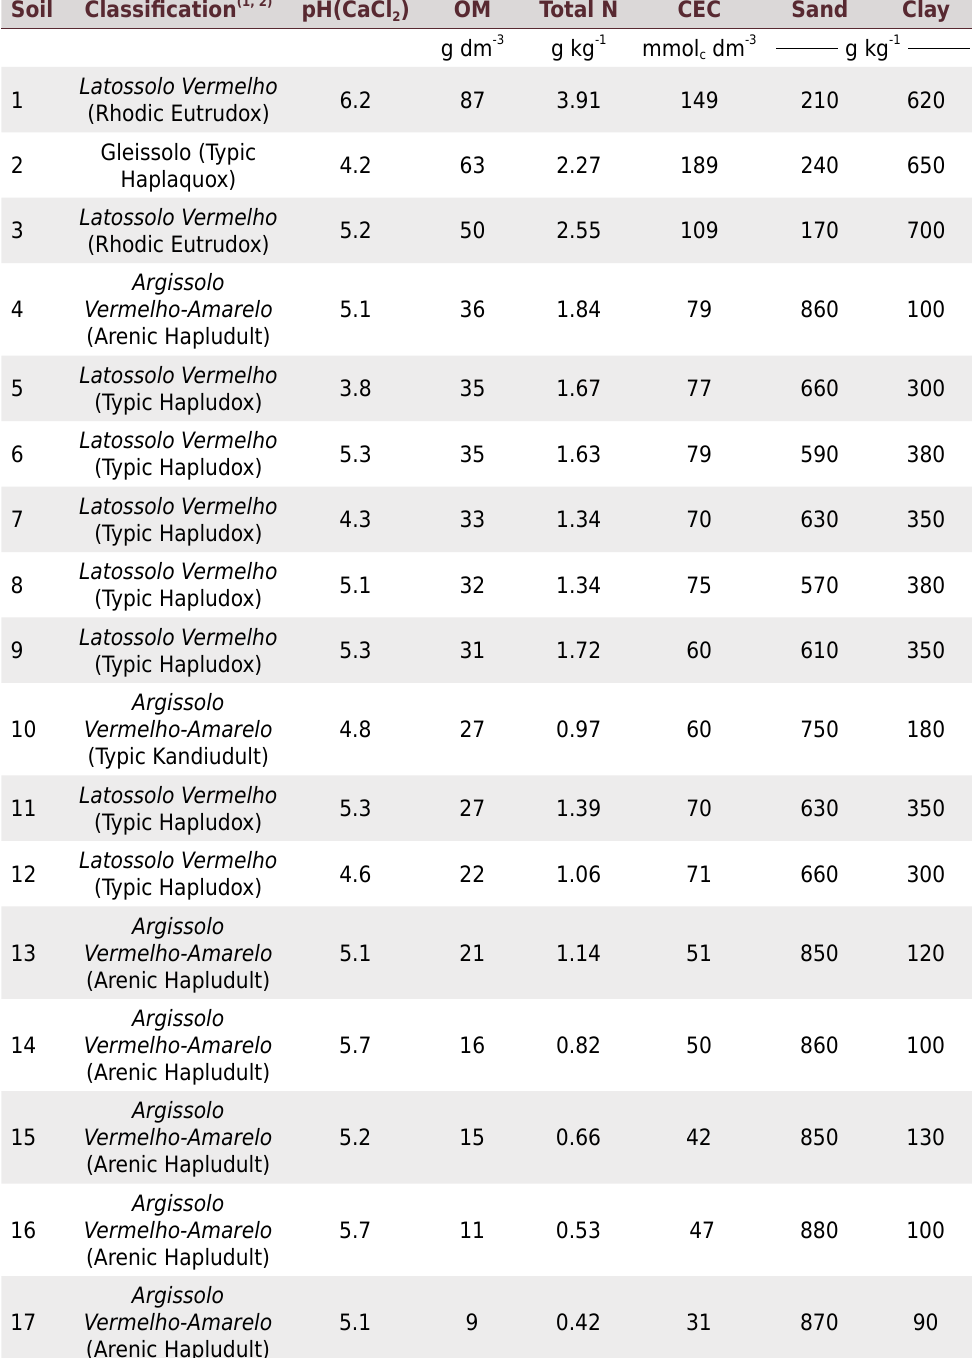
Table 1. Classification and properties of soils studied in the greenhouse experiment and in laboratory analyses for potentially available organic nitrogen